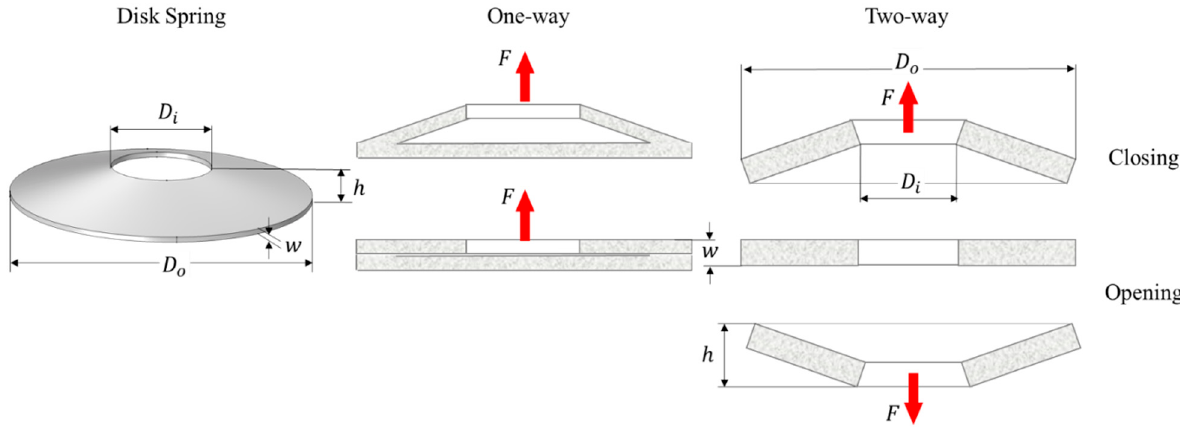
Figure 7. One-way and two-way disc springs’ principles.